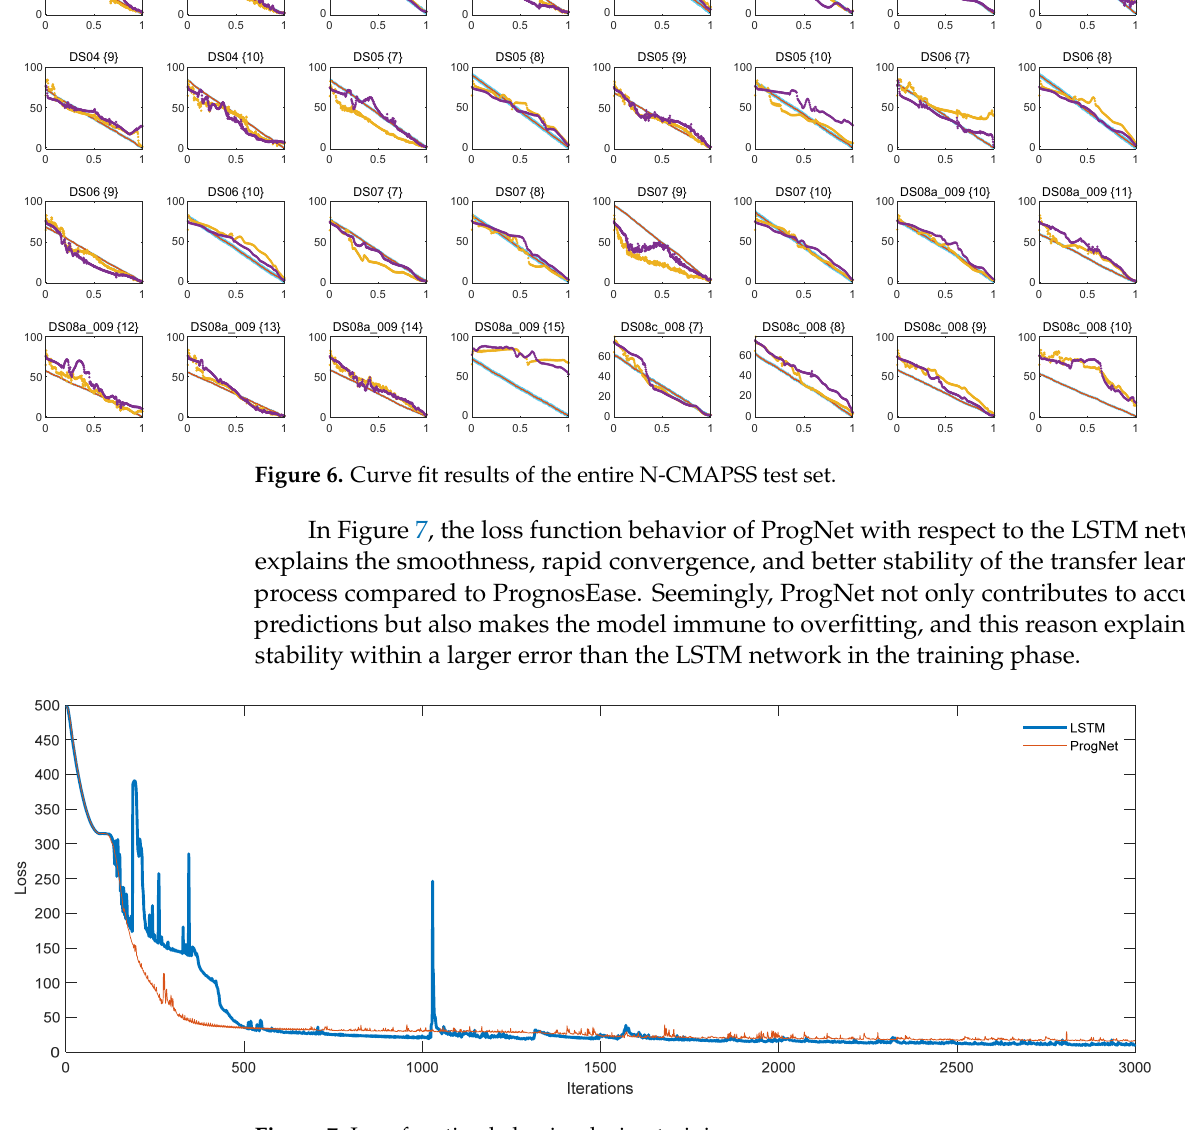
Figure 7. Loss function behavior during training process.